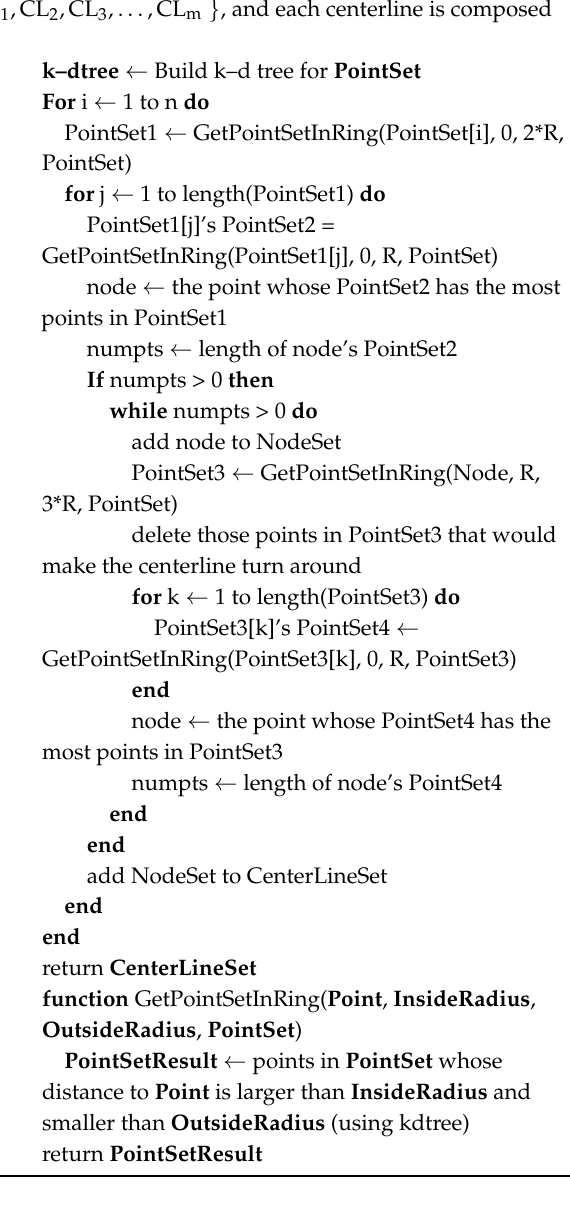
Algorithm 1. RSC (ring-stepping clustering) Algorithm